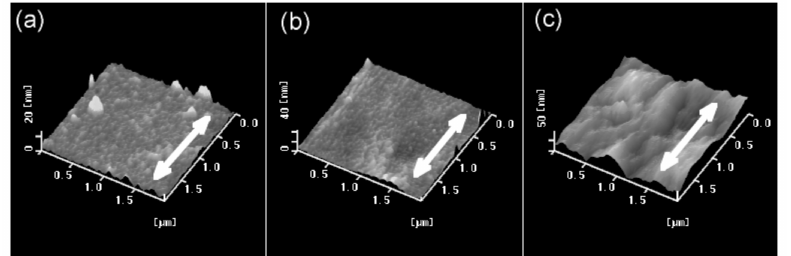
Figure 2. AFM images of the friction-transferred films on the glass substrates; ( a ) PT; ( b ) P3HT; ( c ) P3DDT. The drawing direction of transfer is indicated by the arrow.